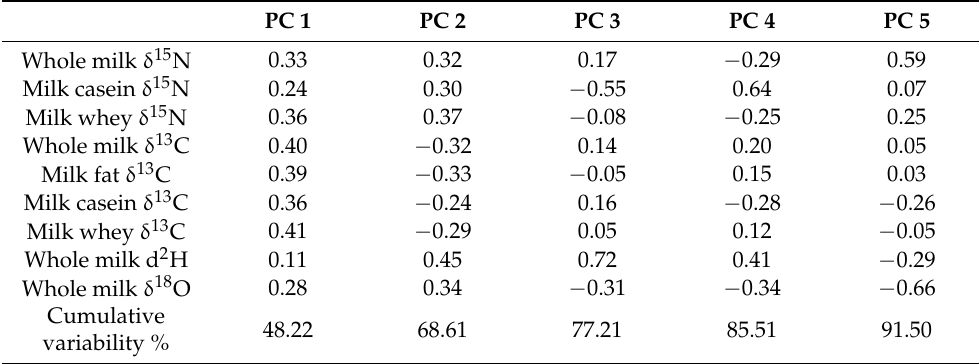
Table 4. Principal component loadings and total cumulative variance are explained by the first five principal